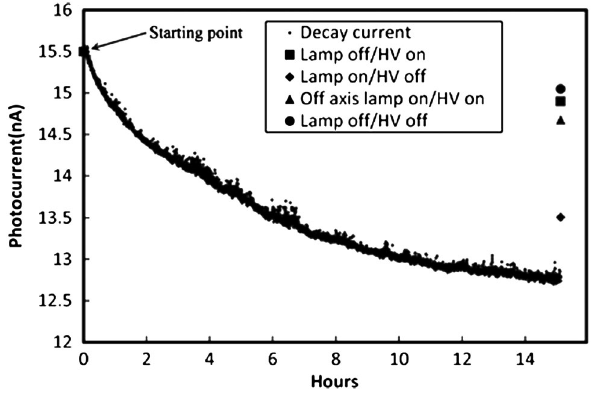
FIG. 3. The stabilization of the photocurrent measured in the diamond sample under different conditions.